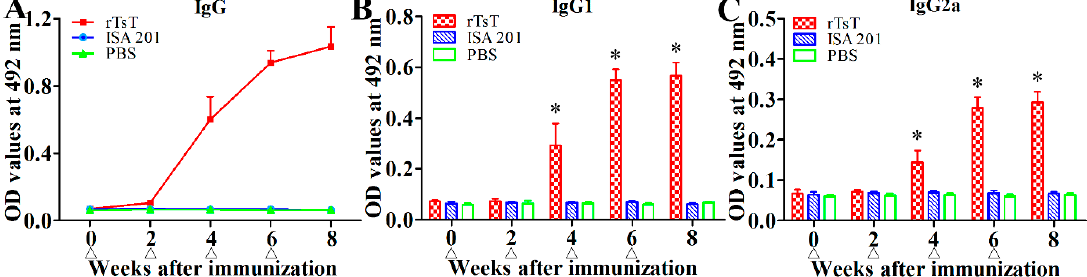
Figure 9. Humoral immune responses against rTsT in immunized mice measured by ELISA. ( A ) Serum level of total anti-rTsT IgG in immunized mice, and adjuvant or PBS control mice. The IgG1 ( B ) and IgG2a ( C ) subclass responses against rTsT were detected at different time points following vaccination. The data are presented as mean ± SD for 20 mice per group. The vaccination time points are marked using triangle ( ∆ ). * Significantly different with respect to the ISA 201 or PBS control group (* p < 0.0001).